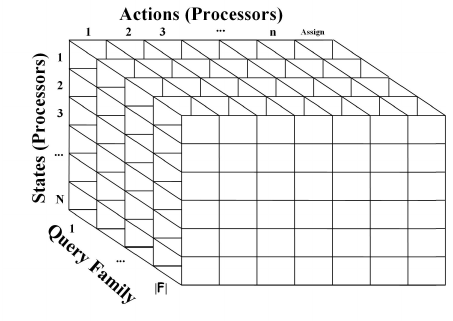
Figure 2. The proposed Q -tables (the ‘assign’ column depicts the ‘assignment’